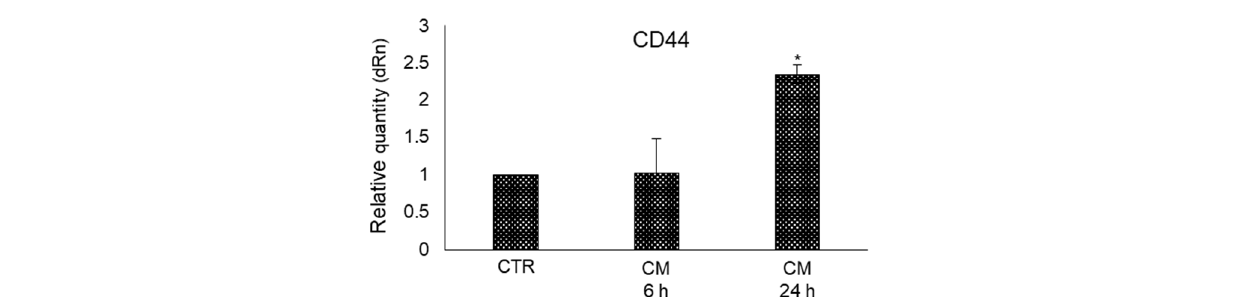
Figure 4. Effect of conditioned medium (CM) from PC3 bone metastasis-derived prostate cancer (PCa) cells on the mRNA expression of osteogenic differentiative markers runt-related transcription factor 2 (Runx2), collagen type I α 1 (Col1 α 1), osteonectin (ON), osterix (OSX), and the pre-osteoblast state marker, cluster of differentiation protein 44 (CD44) in human primary osteoblasts (OB). Transcript levels were evaluated by real-time PCR in OB exposed for 6 and 24 h to CM from PC3 cells. Control cells (CTR) are represented by OB cultured for the same period of time in their specific growth medium. Two experimental CTRs were performed for each exposure time; being both of them set at 1, each histogram reports only one CTR. The histogram indicates the mean ± SD of two different cultures, and each was tested in triplicate. * p < 0.05, ** p < 0.01 versus CTR.